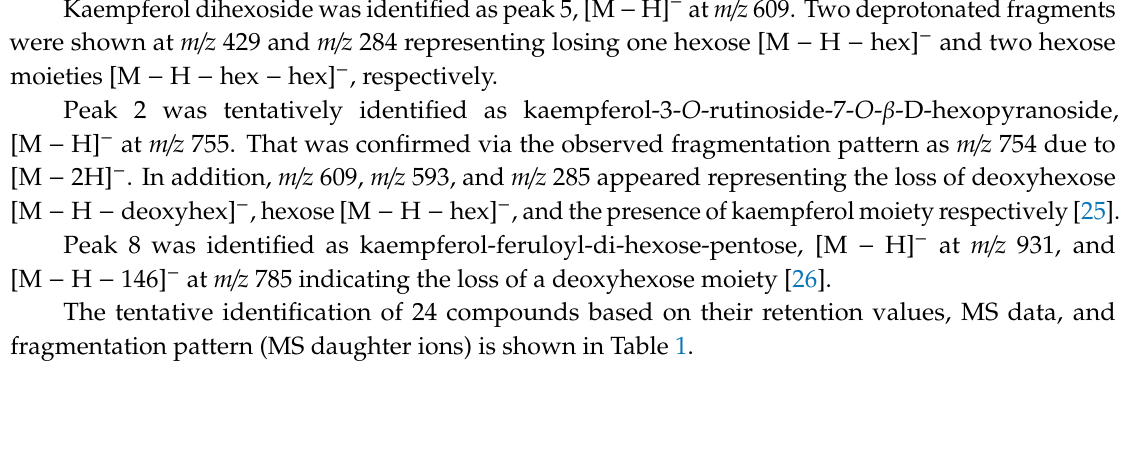
Table 1. Characterization of secondary metabolites in the hydroalcoholic extract of SJ fruits by HPLC-PDA-ESI-MS/MS.